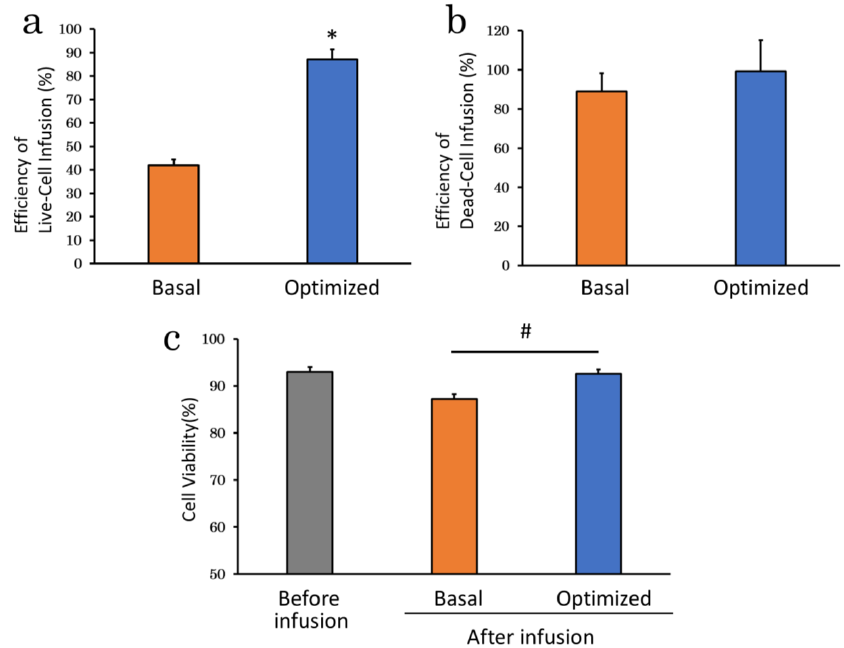
Figure 8. Optimized infusion procedure. ( a ), Efficiency of live-cell infusion under optimized conditions. The optimized infusion procedure significantly improved efficiency of live-cell infusion compared with the basal condition, which were the best results in this study; ( b ), Efficiency of dead-cell infusion of infusion under optimized conditions. Efficiency of dead-cell infusion was slightly higher than the basal condition; ( c ), Cell viability of infusion under optimized conditions. The optimized infusion procedure significantly improved cell viability after infusion compared with the basal condition. * p < 0.01 vs. control. # p < 0.01, between groups.